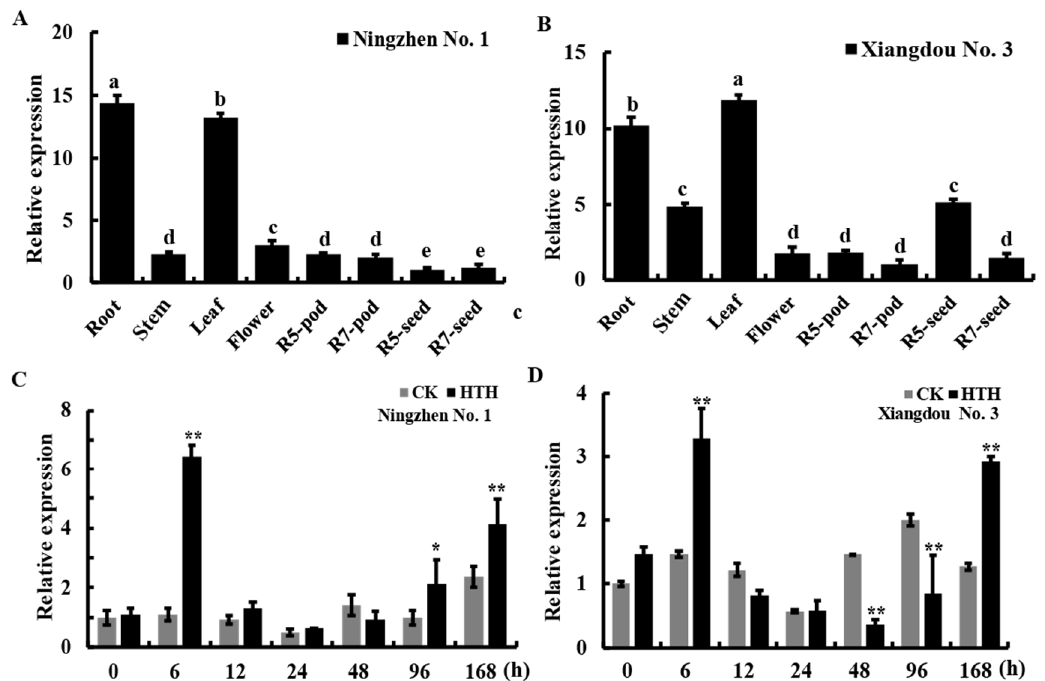
(Figure 2A). In the high-seed-vigor soybean cultivar, Xiangdou No. 3, the transcript level of GmPAL1.1 was highest in the roots and leaves, followed by the stem and the seed at the R5 (beginning of seed development) stage (Figure 2B). Under the HTH stress, compared to the corresponding CK, GmPAL1.1 was significantly up-regulated at 6 h, 96 h, and 168 h ( p < 0.05 or 0.01) in the developing seeds in Ningzhen No. 1 at the physiological maturity (R7) stage (Figure 2C), while markedly ( p < 0.01) up-regulated at 6 h and 168 h and significantly ( p < 0.01) down-regulated at 48 h and 96 h in the developing seeds in Xiangdou No. 3 (Figure 2D).